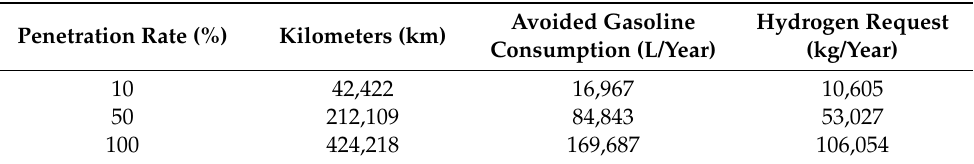
Table 10. Hydrogen request and avoided gasoline consumption for different